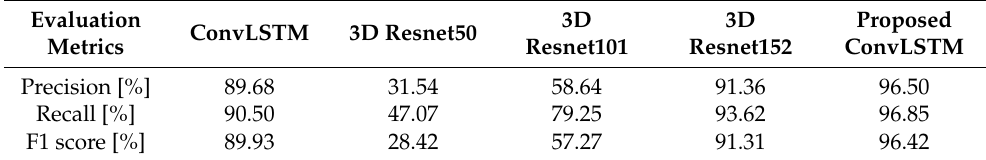
Table 8. The evaluation criterion of the architectures using our dataset.